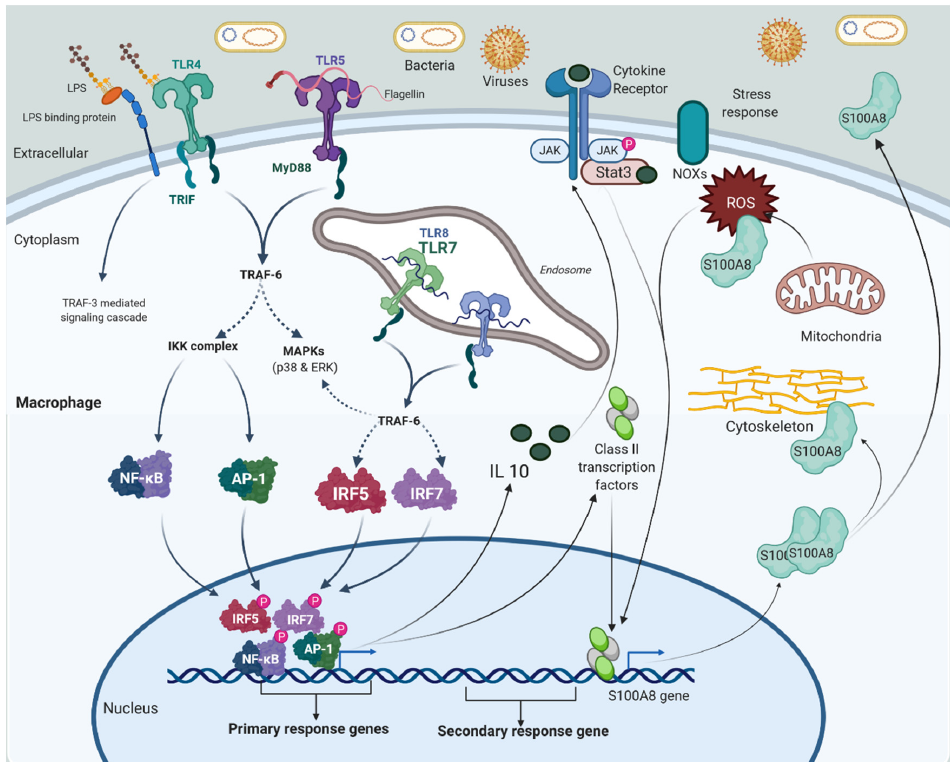
Figure 2. The activation mechanism of macrophages is depicted. Bacterial LPS and endotoxins cause phagocytic macrophages to activate. This activates the TLR-4 receptor on macrophage surfaces, which triggers S100A8 expression. TLR-4 activation enhances the signal via the downstream signaling cascade, activating NF- κ B, AP-1, and IRF-3 transcription factors via non-endosomal and endosomal TLR-4 pathways. These transcriptional regulatory factors regulate primary response genes, IL-10 (an anti-inflammatory cytokine), and class II transcriptional factors, such as C/EBPs, AP-1, and Stat-3. In addition, the expression of S100A8 as a secondary response gene, or late gene, should be raised. IL-10 promotes the expression of S100A8 in macrophages. S100A8 works as an oxidant scavenger in a heterodimer with S100A9, interacting with cytoskeletal proteins for cytoskeleton reorganization and secreting, into the extracellular matrix, via non-classical secretory pathways, its extracellular activity. LPS (Lipopolysaccharides). Created with